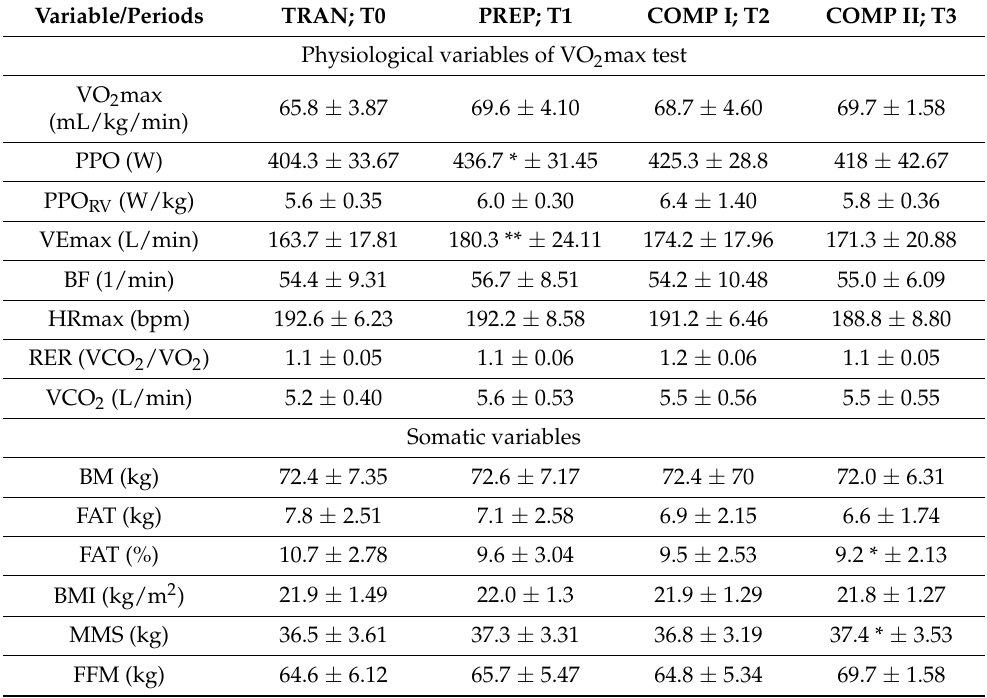
Table 3. Selected physiological variables of the VO 2 max test and body composition of road cyclists in four periods of the training macrocycle (T0, T1, T2, T3). Data are presented as mean ± standard deviation.